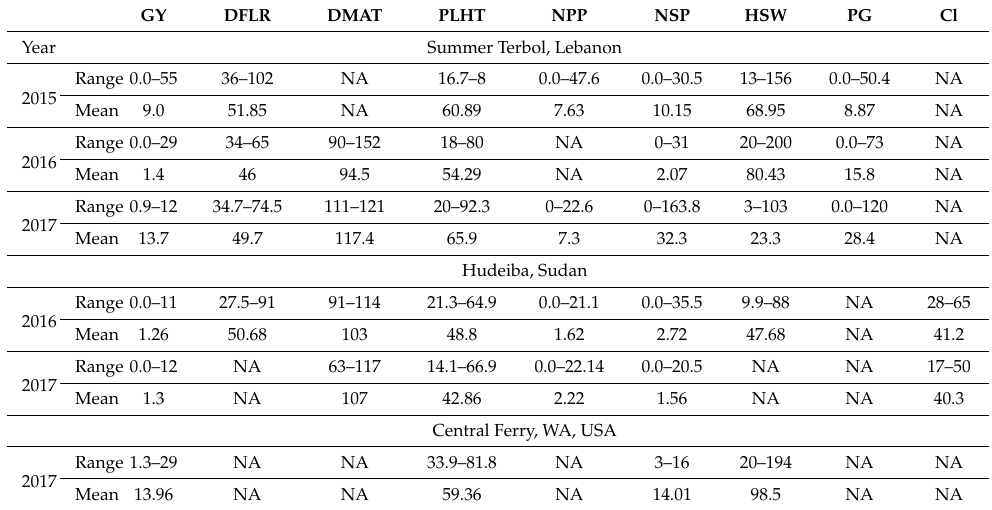
Table 3. Means and ranges for phenotypic and physiological traits recorded in different locations and seasons.